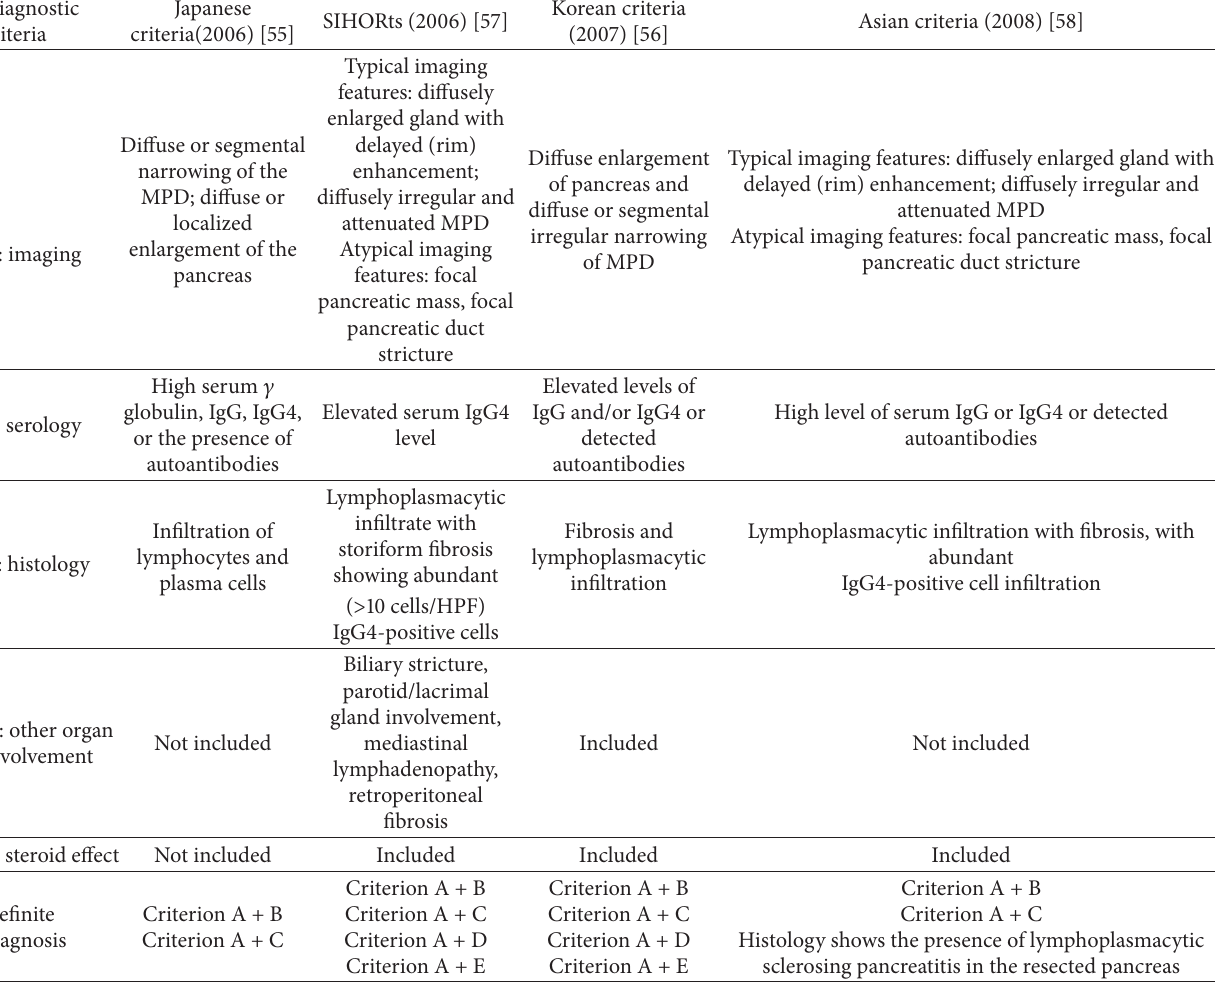
Table 4: Comparisons of diagnostic criteria in different